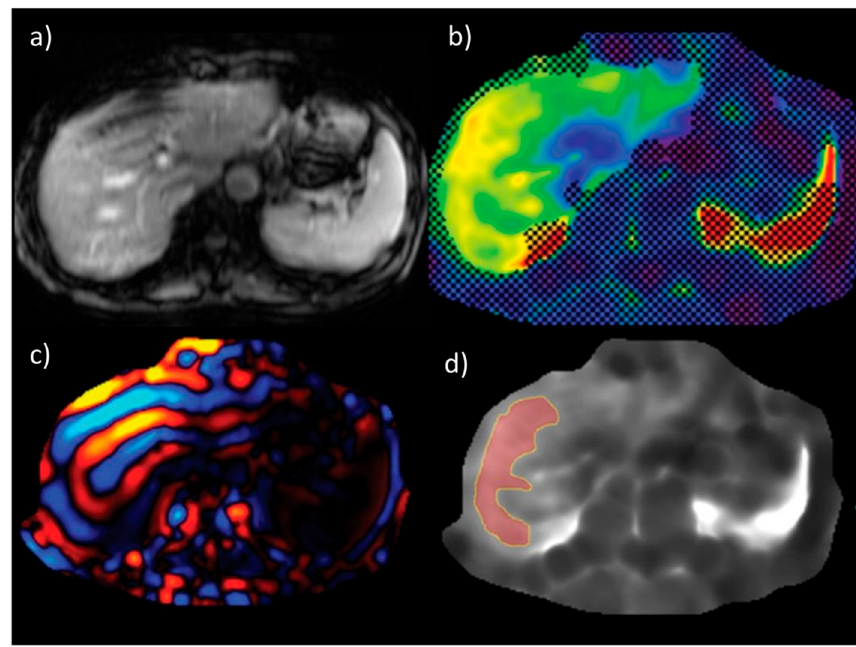
Figure 5. An example of liver stiffness measurement by magnetic resonance elastography ( a ) anatomic images ( b ) confidence map of an elastogram ( c ) wave image data ( d ) elastogram with free drawn region of interest. Figure from Chang, W., et al., Liver Fibrosis Staging with MR Elastography: Comparison of Diagnostic Performance between Patients with Chronic Hepatitis B and Those with Other Etiologic Causes. Radiology 2016 , 280 , 88–97 [62].